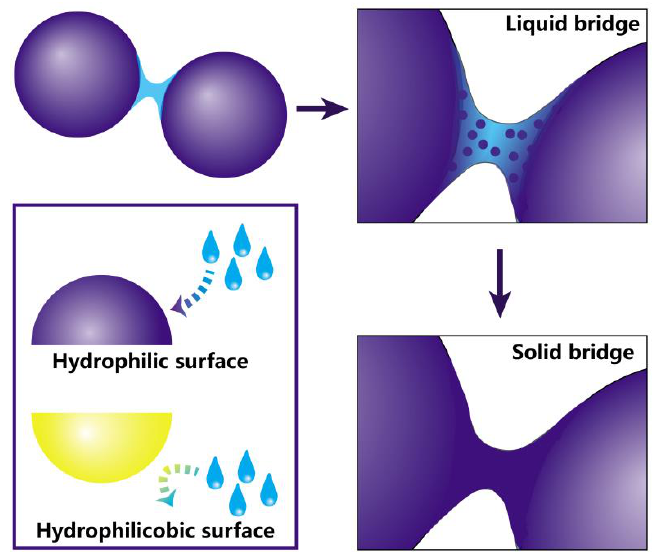
Figure 1. The moisture absorption process of particles.